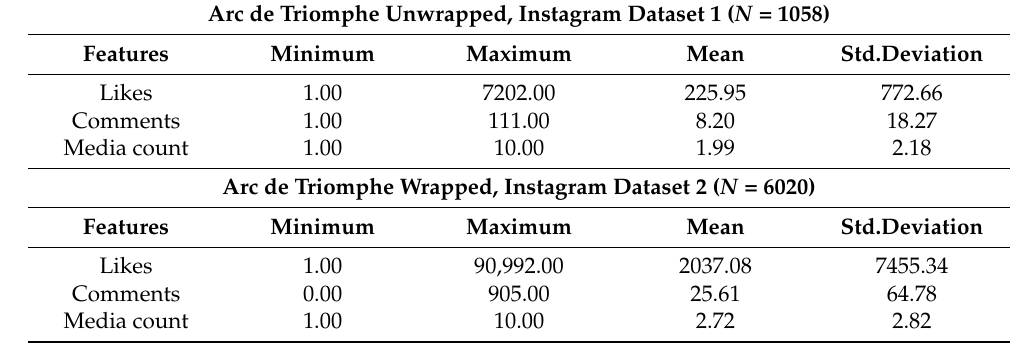
Table 1. The statistical description of the Arc de Triomphe Instagram datasets.